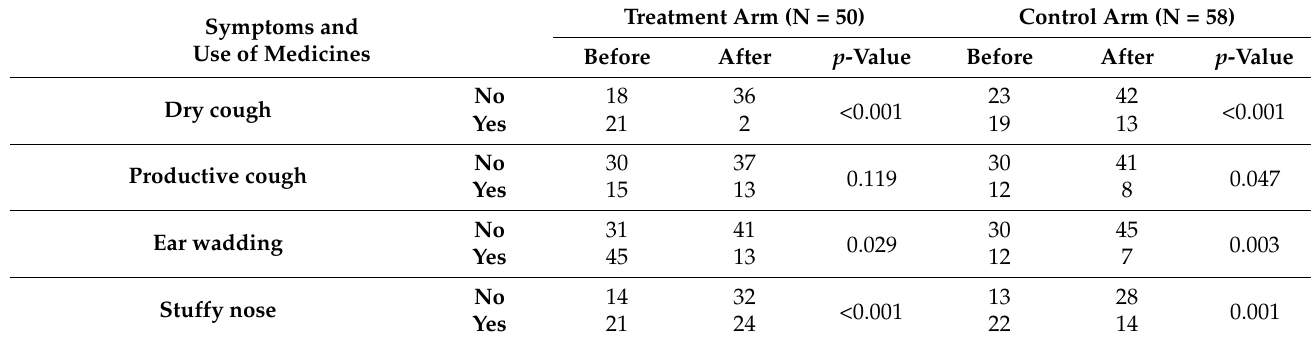
Table 4. Number of study participants by symptoms at initial positive (“before”) and first nega- tive (“after”) swab test for SARS-CoV-2, with exact significance probability ( p -value) in both arms (treatment versus